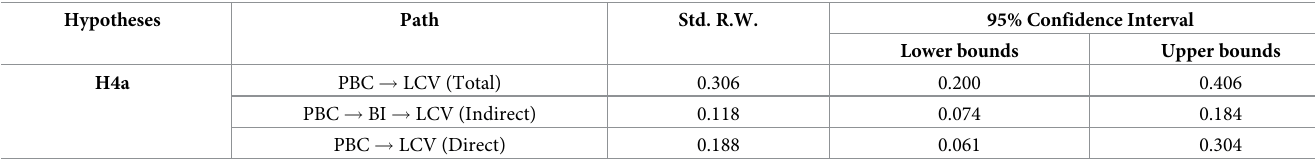
Table 12. Mediation effect analysis